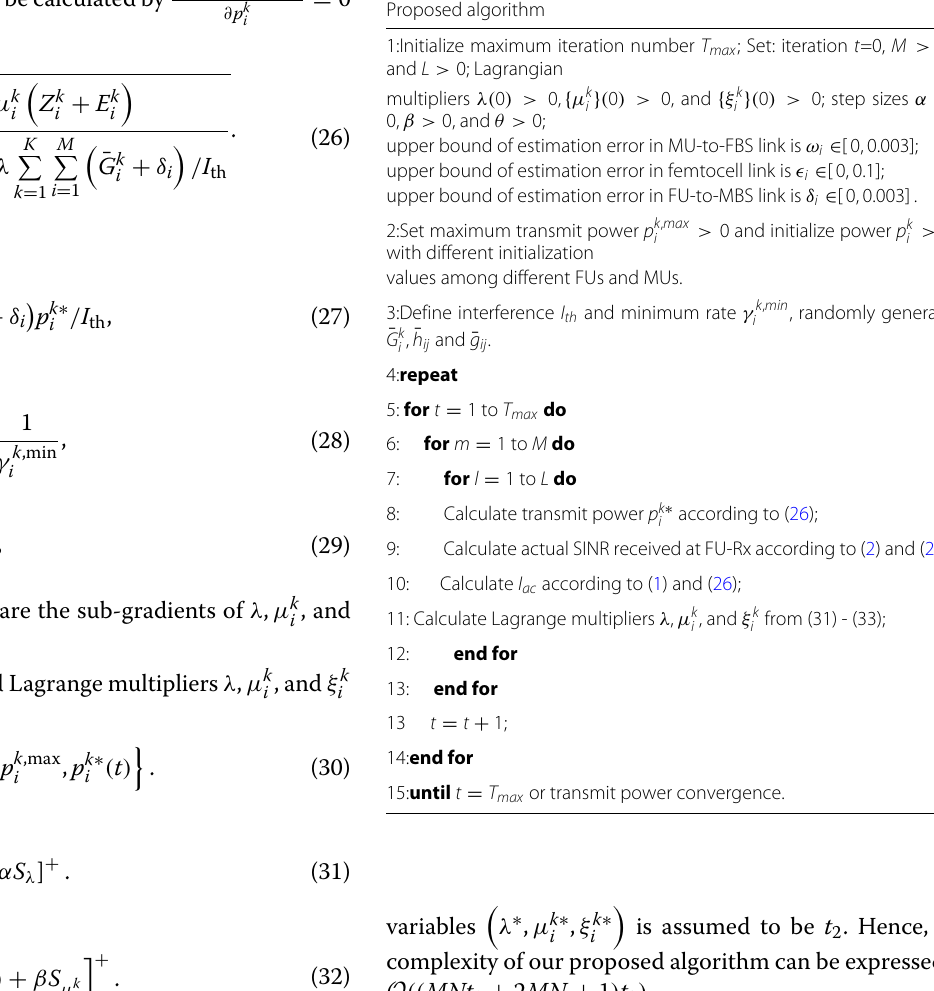
Table 2 Proposed RPA algorithm Proposed